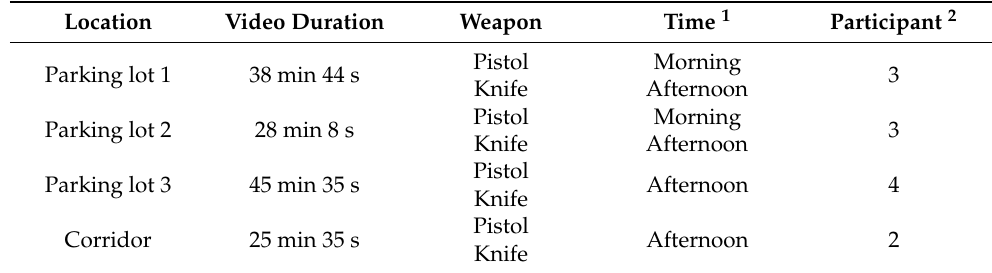
Table 2. Data collection